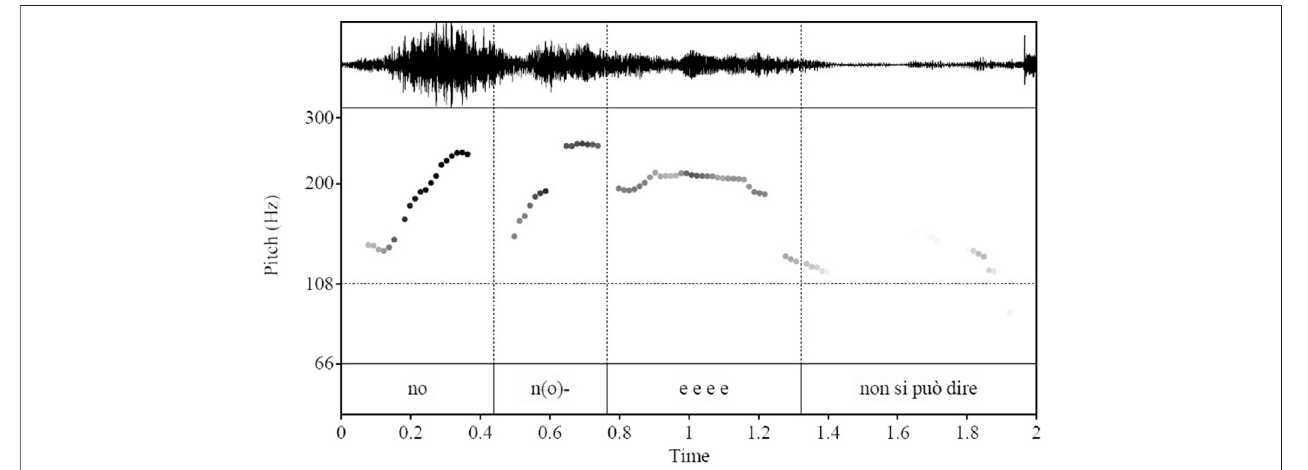
FIGURE 2 | The pitch contour of Furio ’ s turn (4. line